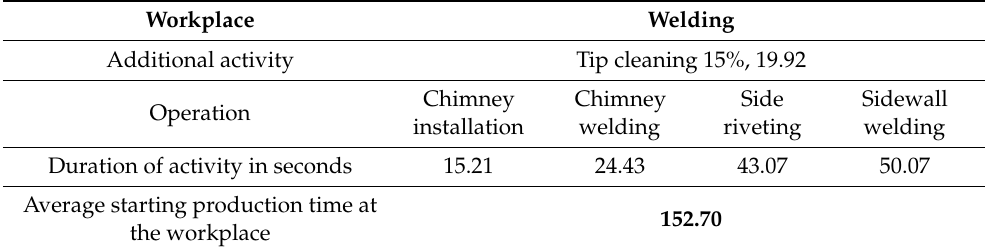
Table 3. Average starting production time (seconds) at the workplace Welding.